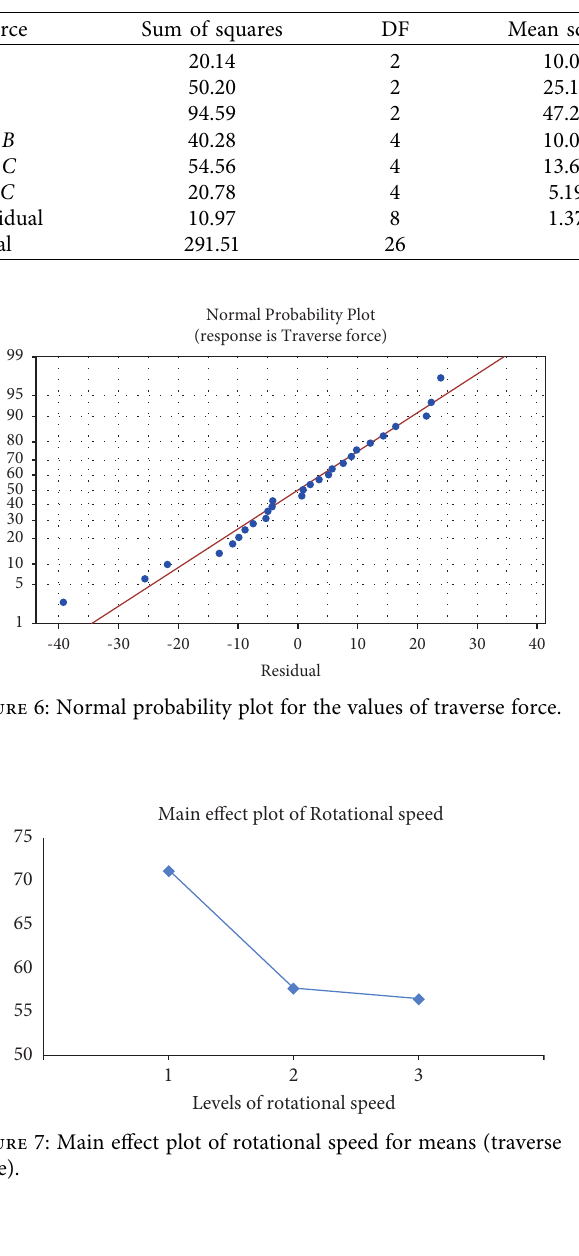
Table 6: The ANOVA table for traverse force.